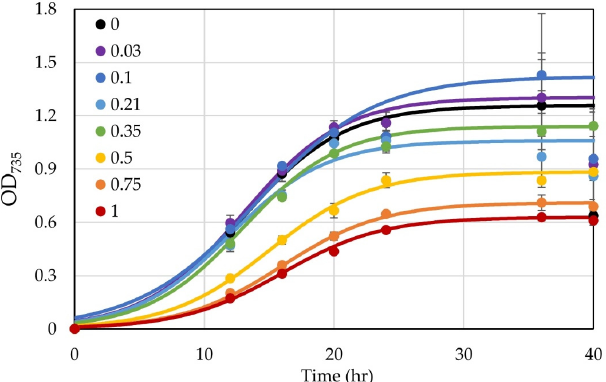
Figure 7. The growth of H. modesticaldum with varying concentrations of xylose from 0 to 1 %. Xylose concentrations (%) are displayed in the legend. Data points represent the average, and error bars represent the standard deviation of the biological triplicate ( n = 3). Curves represent fittings of points to the logistic function [13]. The P xyl promoter with the xylR gene (based on genes from the operon from Clostrid- ioides difficile ) was cloned in front of lacZ to make plasmid pALX3. H. modesticaldum trans- conjugants harboring pALX3 were grown with a range of xylose concentrations, and cel- lular extracts were prepared from log-phase cells. We found a strikingly linear correlation (R 2 = 0.944) between xylose concentration and β -gal activity between 0.03 and 0.3% xylose (Figure 8). The activities ranged from 0.02 to 0.16 U/mg protein. These activities place this promoter at the lower end of the strength scale. Concentrations of xylose above 0.3% yielded similar or lower promoter activity, with a peak around 0.5% xylose (Figure S1). This is most likely due to the negative effects of xylose upon growth.